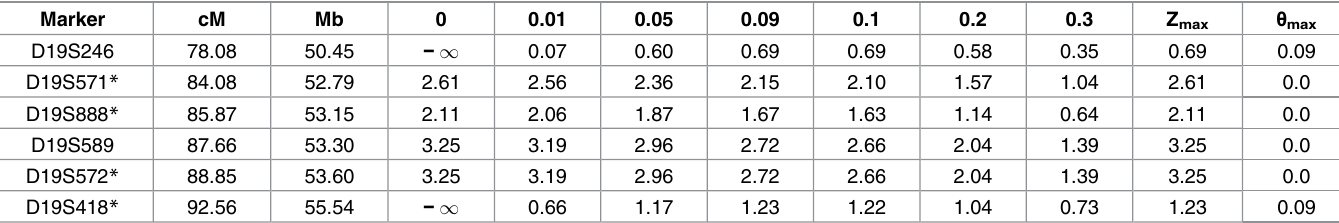
Table 3. Two-point LOD scores and microsatellite markers used for linkage analysis of PKCC214.